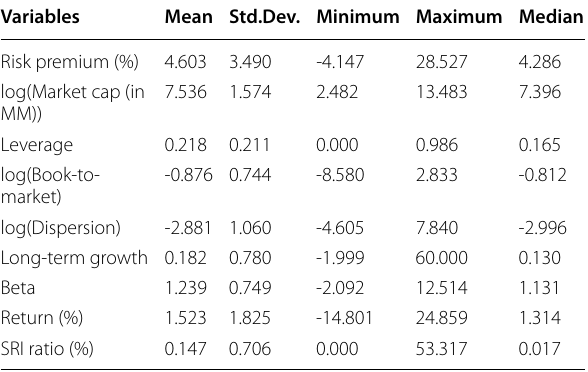
Table 2 Descriptive statistics of continuous variables for the full sample of 20,500 observations